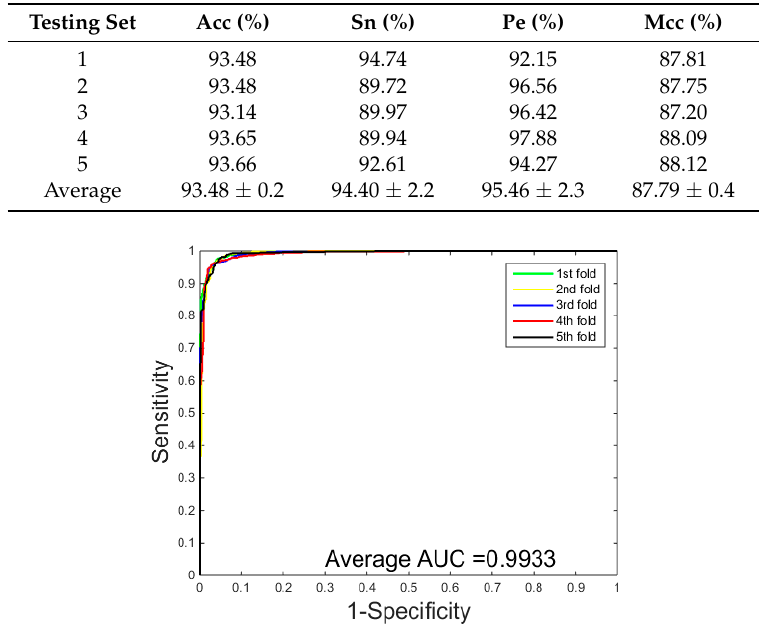
Table 2. Five-fold cross-validation results using our proposed method on the H. pylori dataset.